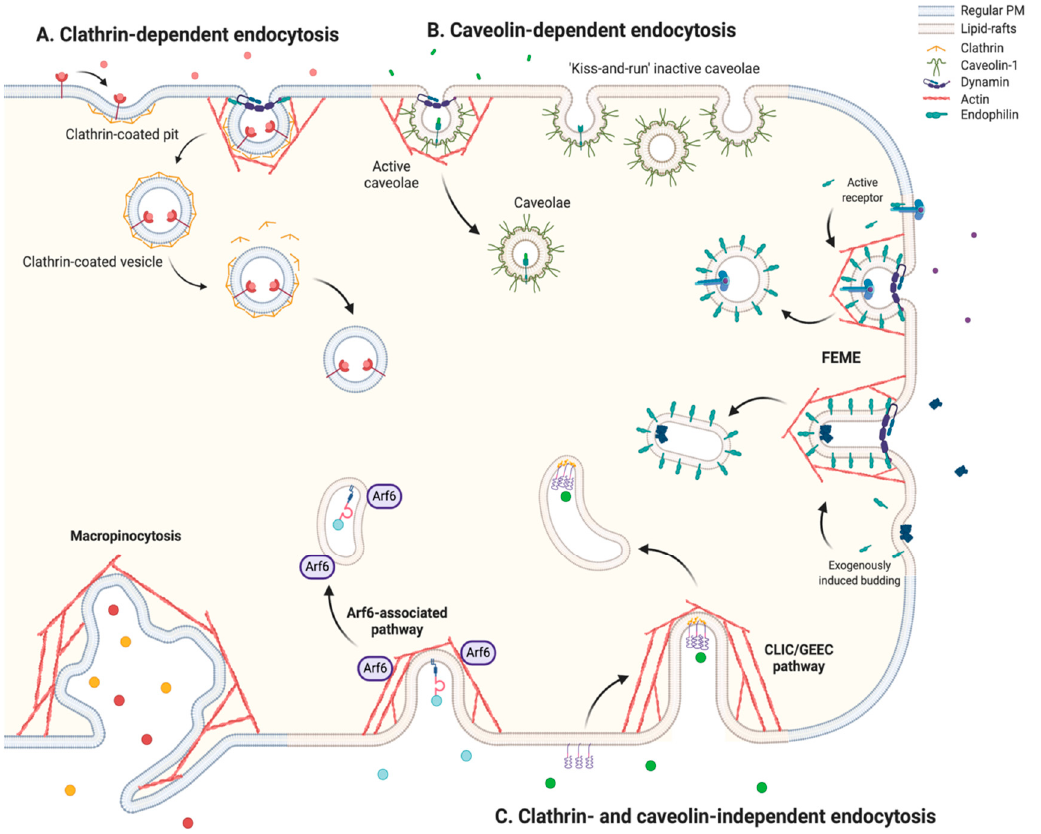
Figure 1. General schematic of the different endocytic mechanisms by pinocytosis, classified as ( A ). clathrin-dependent, ( B ). caveolin-dependent and ( C ). clathrin- and caveolin-independent (FEME, CLIC/GEEC pathway, Arf6 and macropinocytosis). (Created with BioRender.com).